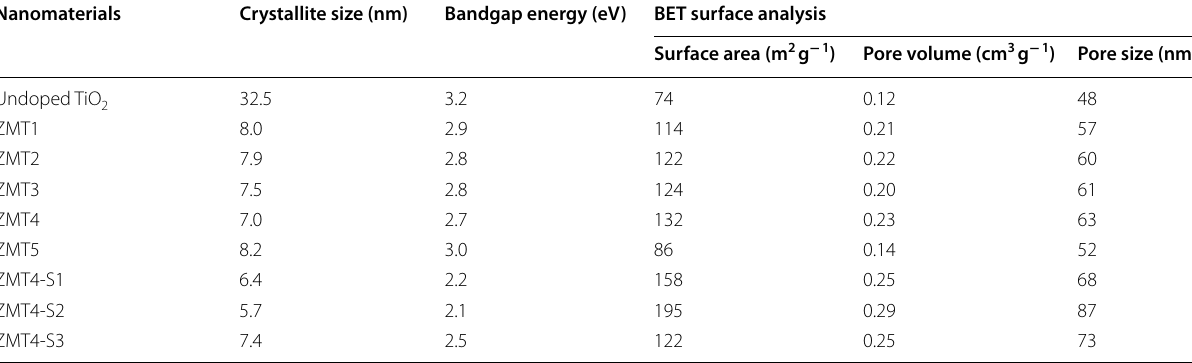
Table 6 Comparative crystallite size, bandgap, surface area, pore size and pore volume values of all synthesized catalysts